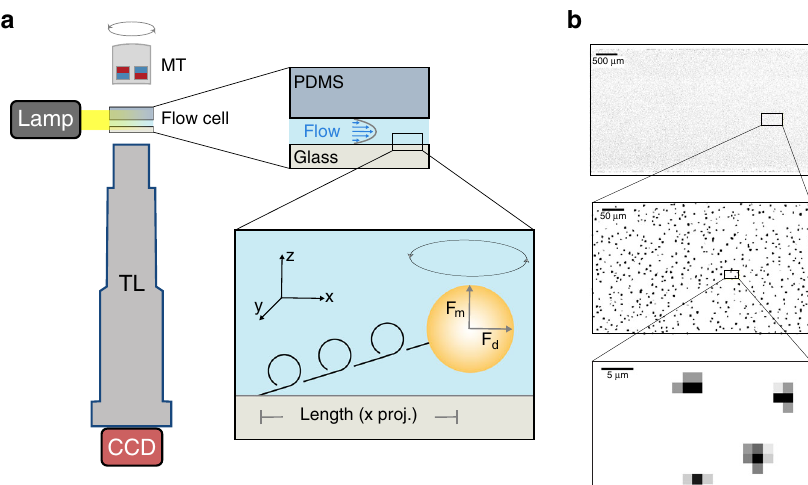
Fig. 1 Principle of fl ow magnetic tweezers. a The fl ow cell is mounted on a x - y translation stage with a fi ber illuminator (Lamp). Beads are imaged with a 7× telecentric lens (TL) mounted on a 29 Megapixel CCD camera. Antiparallel magnets (MT) are mounted above the fl owcell. The fl owcell consists of a PEG-functionalized glass coverslip and a PDMS lid with an embedded fl ow lane. DNA molecules are tethered to the surface using biotin-streptavidin attachment. The total force on each molecule is the sum of the magnetic force ( F m ) due to MT and drag force ( F d ) due to fl ow. Magnetic beads tethered to the DNA molecules are locked in the magnetic fi eld and linking number of the molecules can be manipulated by rotating the magnets. Manipulation of DNA length and topology can be monitored by tracking beads in the x - y plane. b A representative fi eld of view (5.2 mm by 3 mm) from a single experiment containing 53,831 microspheres (diameter, 1 µ m) enlarged by 10× and 100× to show individual